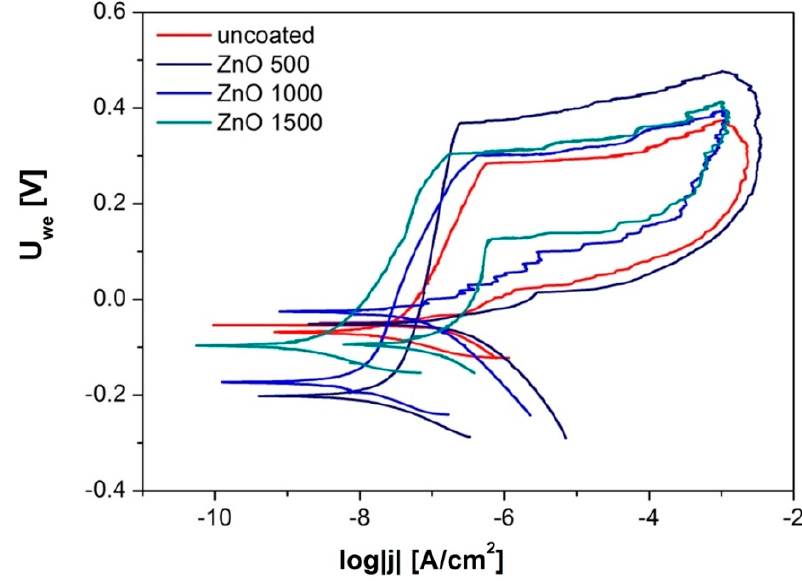
Figure 7. Anodic polarization curves for an uncoated sample and samples with ZnO layers.